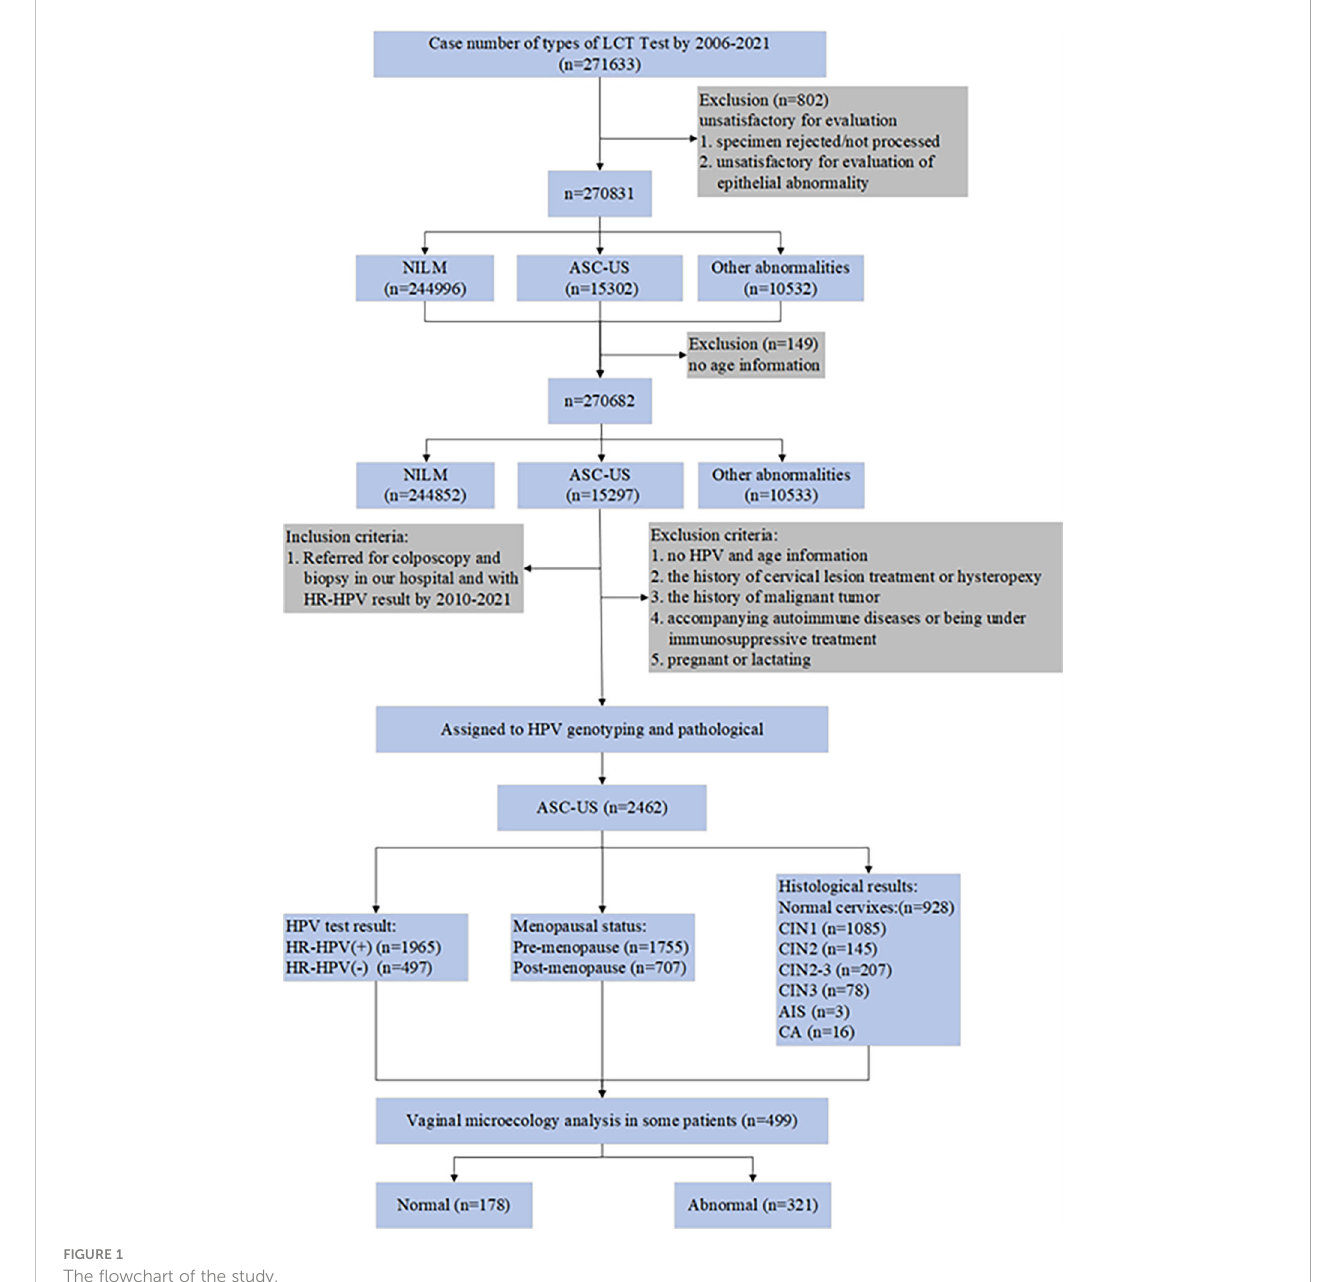
FIGURE 1 The fl owchart of the